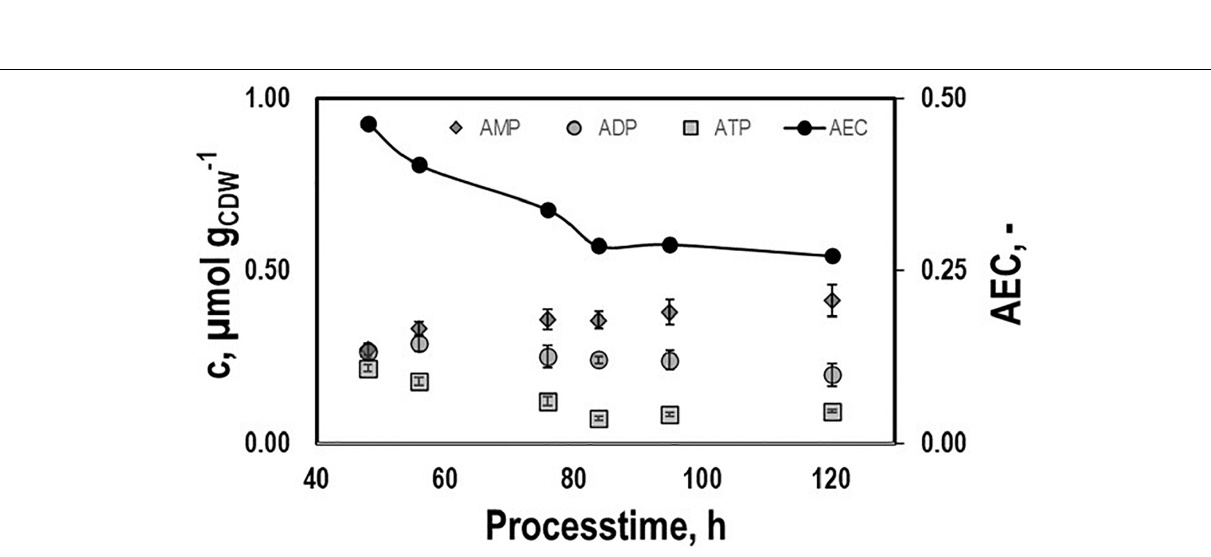
Frontiers in Bioengineering and Biotechnology |